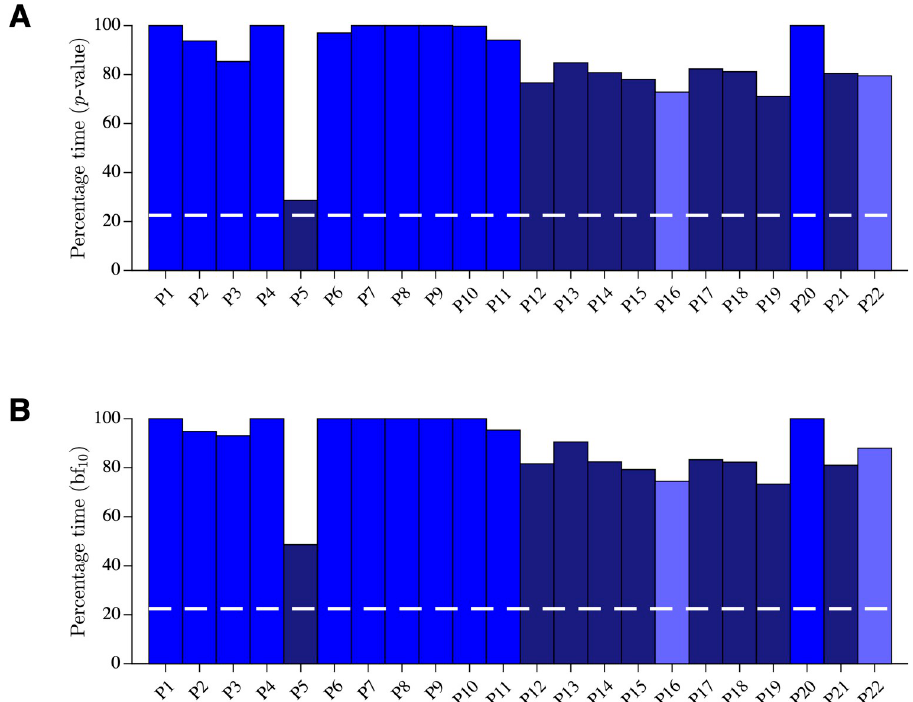
Fig 7. All participants. A . Percentage of time over the first 0.4 s during which the angle derivative of the after-effect trajectory was statistically null or negative using t -test p -values. Dashed white line represents model prediction. Color code for the participants: blue , behavior incompatible with the reoptimization model; dark blue , behavior partially compatible with the reoptimization model; light blue , behavior with no effect of training. B . Same as A using Bayes